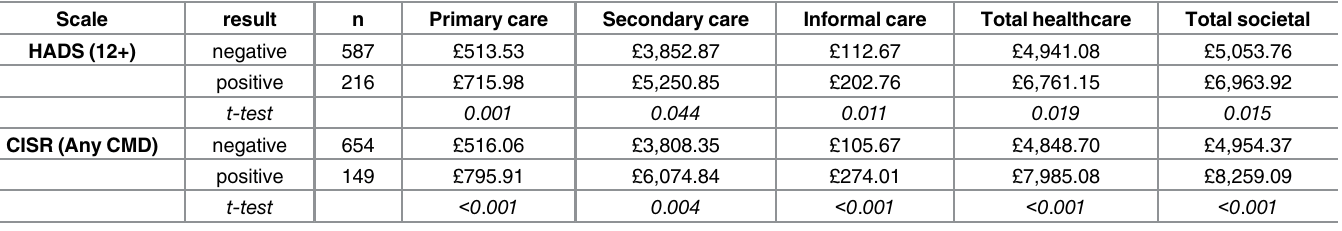
Table 4. Comparative 3-year mean healthcare and societal costs (2011 – 12 prices) between groups of patients with positive and negative results on HADS (cut-off 12+) and CISR (any CMD). Scale